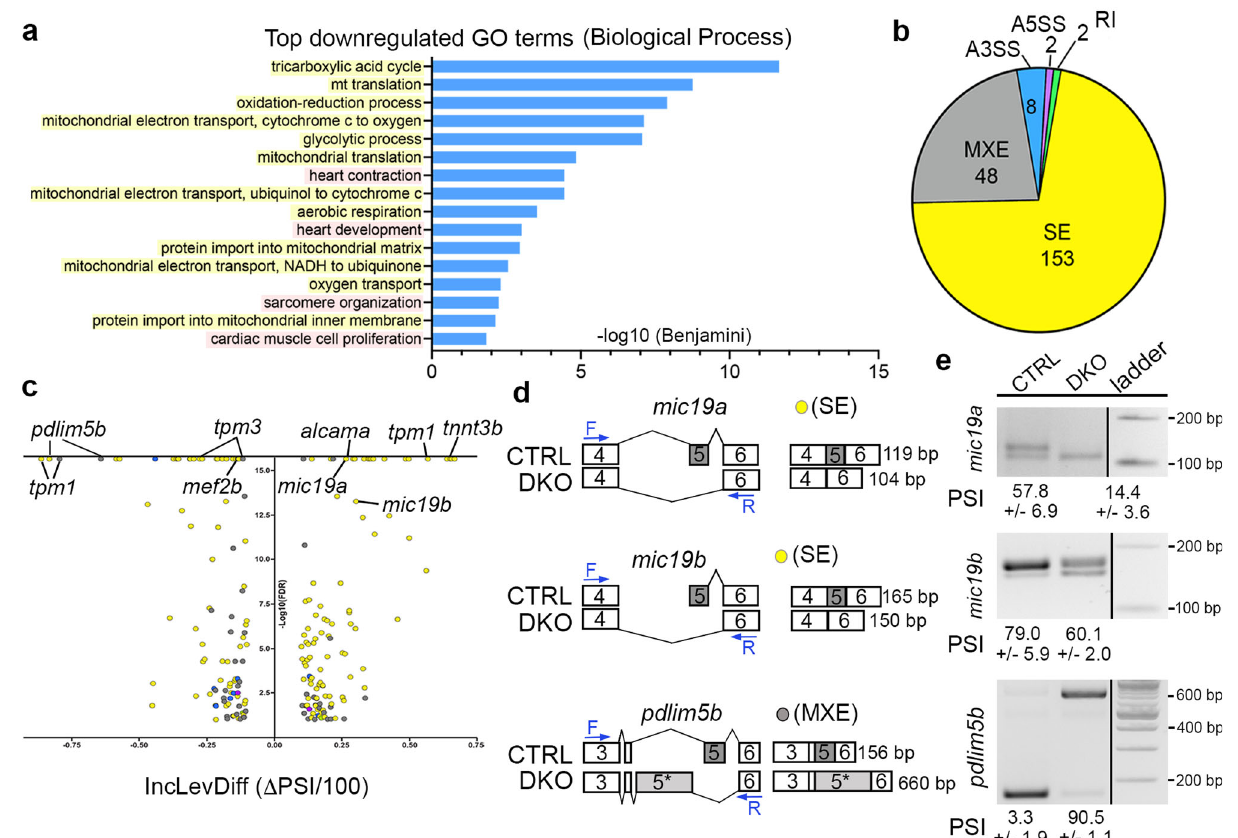
Fig. 4 | Rbfox proteins are required for expression and alternative splicing of transcripts encoding mitochondrial, cytoskeletal, and sarcomere compo- nents. a GO analysis showing biological processes associated with downregulated transcripts in DKOhearts. Yellow represents mitochondria-associated terms, while pinkshowsheartmuscleterms. b Piechartdepictingtheproportionsofdifferential alternative splicing events in each category. Abbreviations: Skipped exon (SE), mutually exclusiveexon(MXE),alternative 3 ’ splicesite(A3SS),alternative 5 ’ splice site (A5SS), and retained intron (RI). c Volcano plot showing the inclusion level